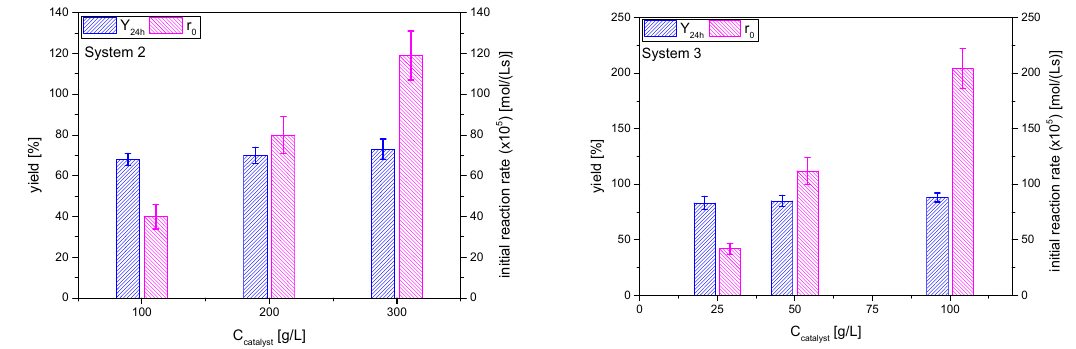
Figure 12. E ff ect of catalyst amount on the yield of ketals 2 and 3 at 24 h and the initial reaction rate (Reaction conditions: butanone / glycerol or cyclohexanone:glycerol molar ratio, 6:1; temperature, 40 ◦ C).